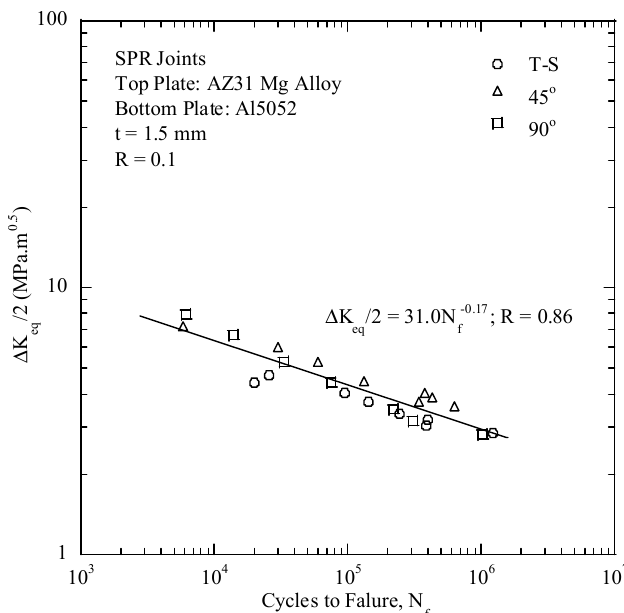
Figure 13. Experimental fatigue lifetimes of the SPR joint specimens under various loading condi- tions as a function of the equivalent stress intensity factor amplitude. as a function of the equivalent stress intensity factor